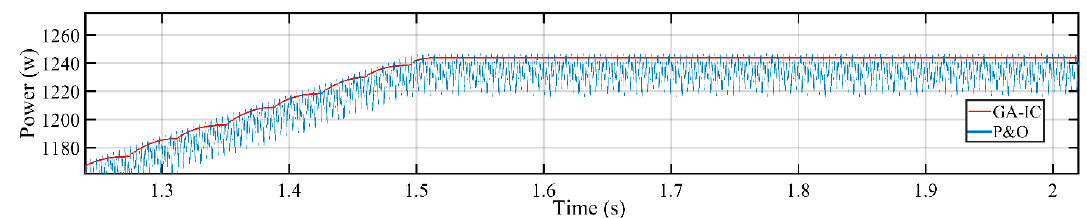
Figure 24. Case 2 power comparison of modified GA-IC vs. P&O.